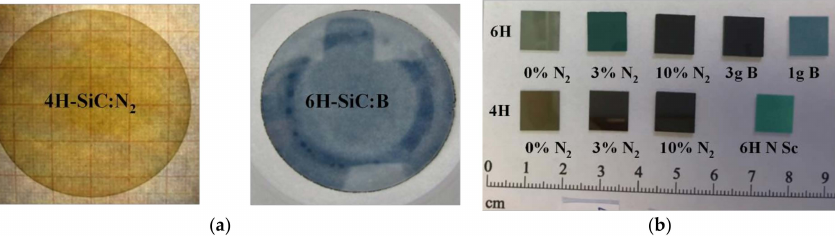
Figure 3. Examples of wafers cut from the bulk crystals obtained by the PVT method ( a ) and smaller samples cut from the wafers used for characterization ( b ).